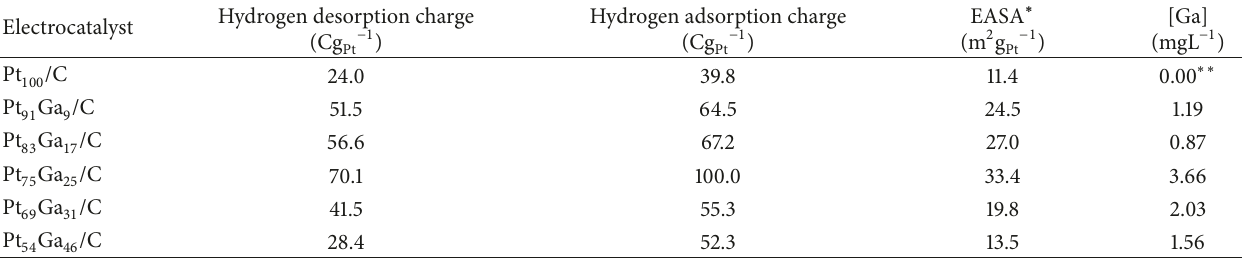
Table 3: Hydrogen desorption/adsorption charge, EASA, and [Ga] of the PtGa/C electrocatalysts.